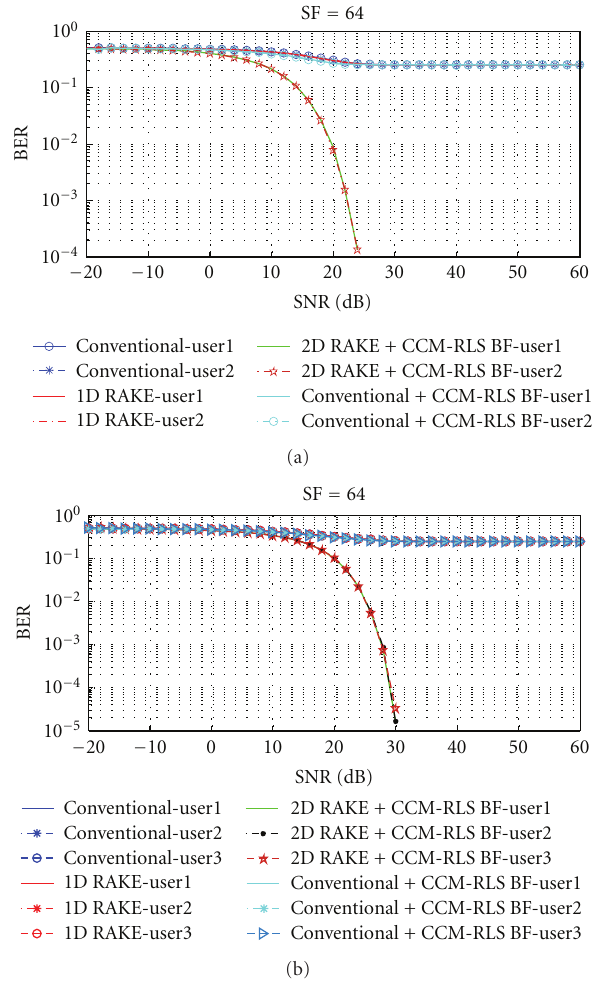
Figure 5: Performance of di ff erent conventional and proposed WCDMA receivers considering 4-element antenna array in 2-path AWGN fading channel for (a) 2 users, (b) 3